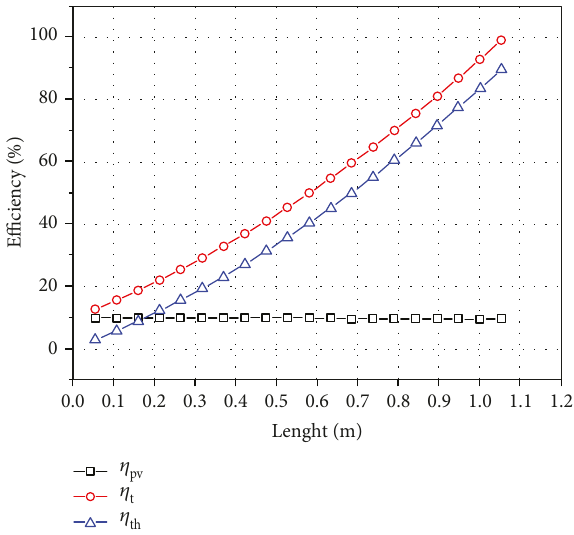
Figure 6: Variation of the e ffi ciency of the PV/T air